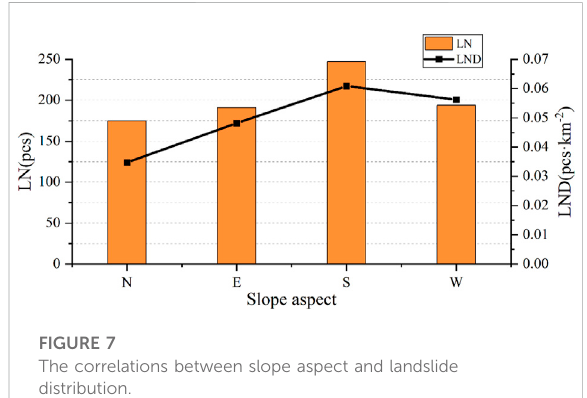
FIGURE 7 The correlations between slope aspect and landslide